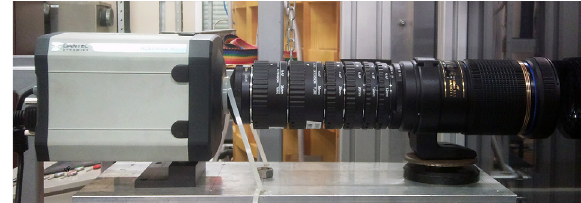
Fig. 2. The sCMOS camera used in measurements connected to two sets of distance rings and 180 mm 1:1 micro lens.